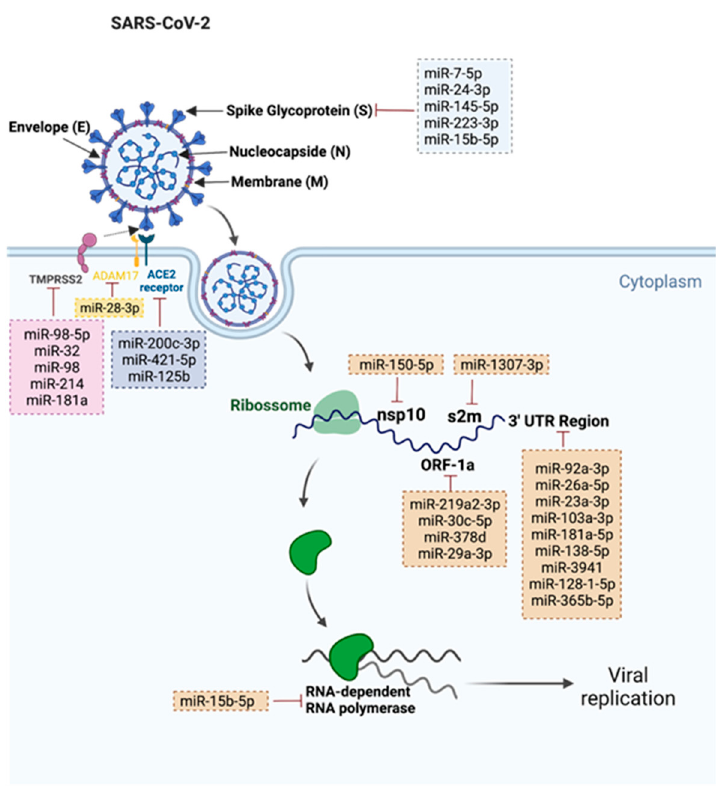
Figure 1. Representation of the 31 validated SARS-CoV-2 miRNAs and their respective targets. This figure was created at BioRender.com (accessed on 12 July 2022).